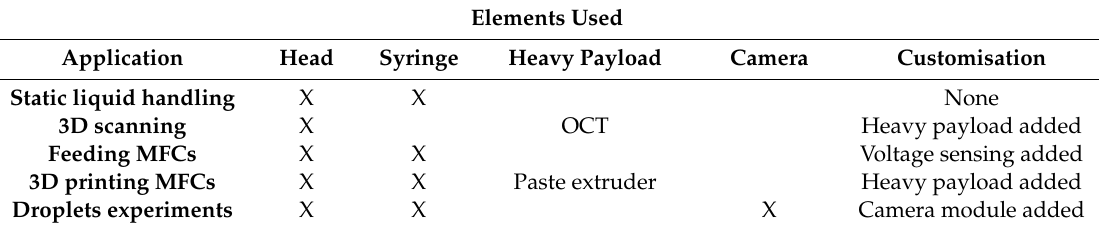
Table 2. How the available modules are used in EvoBot